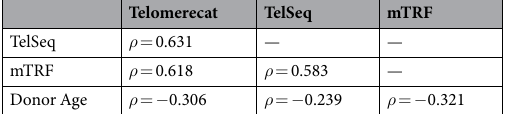
Table 1. Results for the comparisons between Telomerecat, TelSeq, mTRF and Donor